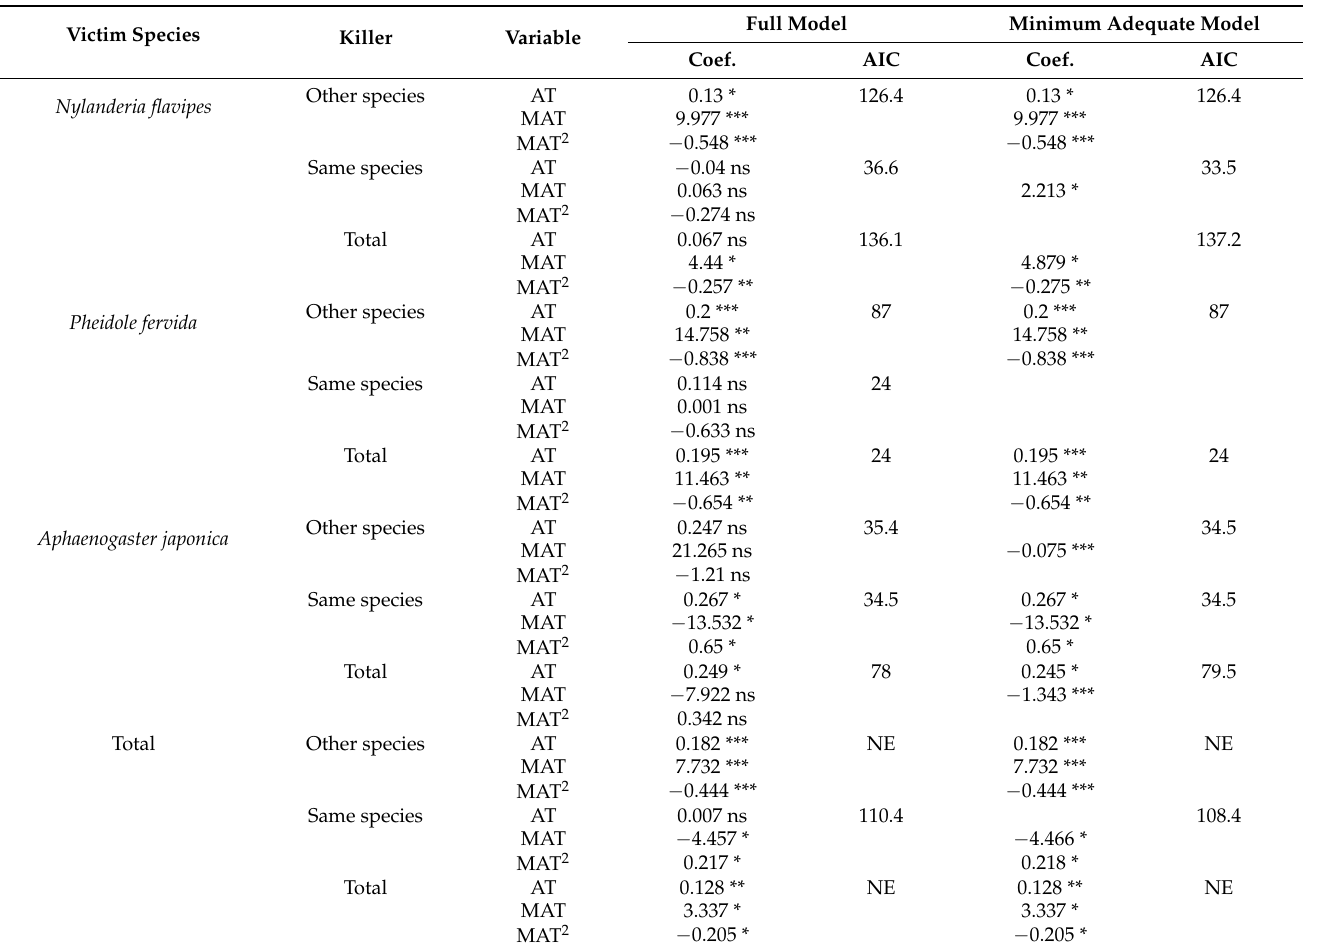
Figure 3. Mortality rate (%) of abundant ant species caused by food competition along temperature gradient. ( a ) Mortality of Nylanderia flavipes from interspecific competition, ( b ) mortality of N. flavipes from intraspecific competition, ( c ) mortality of Aphaenogaster japonica from interspecific com- petition, and ( d ) mortality of A. japonica from intraspecific competition. The experiment was per- formed with eight replicates at each temperature condition, and their mortality rates were presented in the scatter plot. The fitted lines are based on the linear or quadratic regression models according to significant influences shown in Table 6. MAT: mean annual temperature.